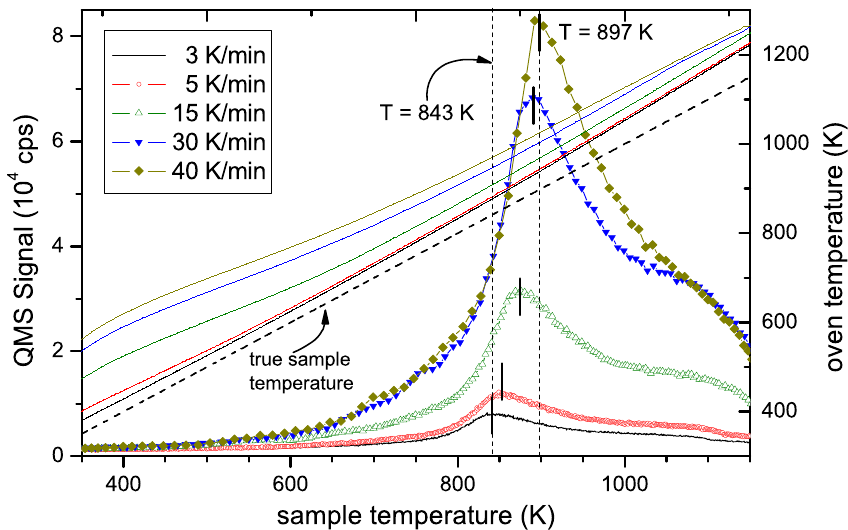
Figure 6. TPD spectra as a function of sample temperature for different temperature ramps (left-hand scale). The temperature of the desorption maximum shifts for quicker temperature ramps to higher temperatures. Also shown are the oven temperatures (solid lines with corresponding colour) required to reach the sample temperature for the different temperature ramps (right-hand scale). The true sample temperature is shown as a dashed line.